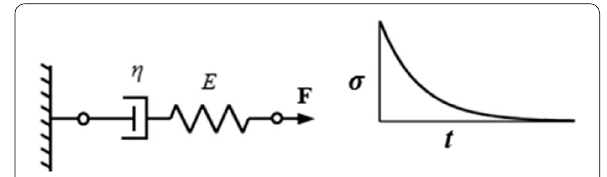
Figure 3 Maxwell model and stress relaxation curve